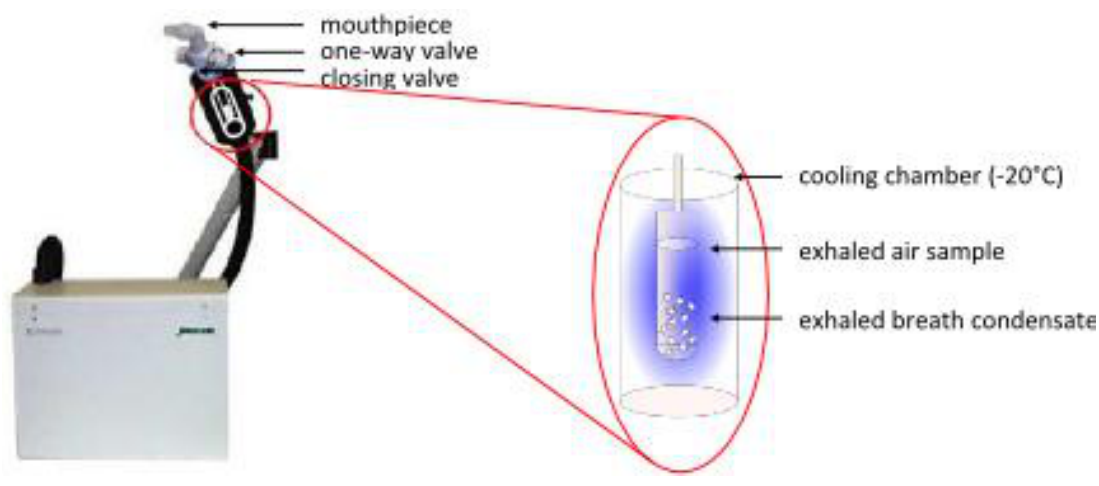
Figure 7. Illustration and diagram of the ECoScreen device for collecting